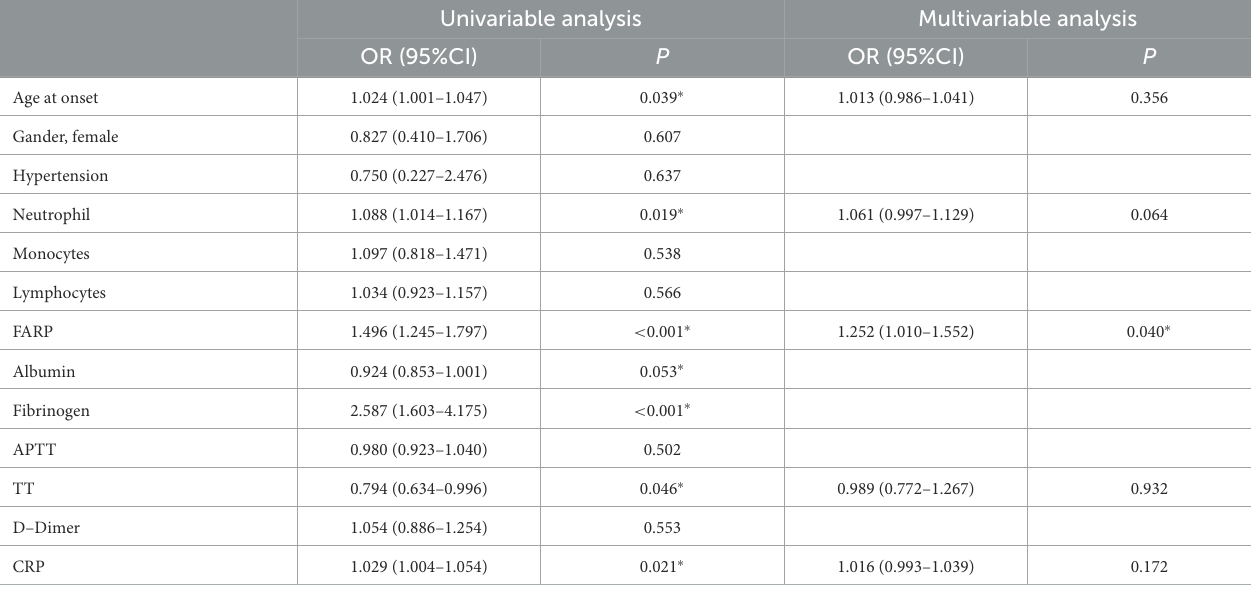
TABLE 7 Binary logistic regression of disease prognosis in patients with anti-NMDAR encephalitis. Univariable analysis